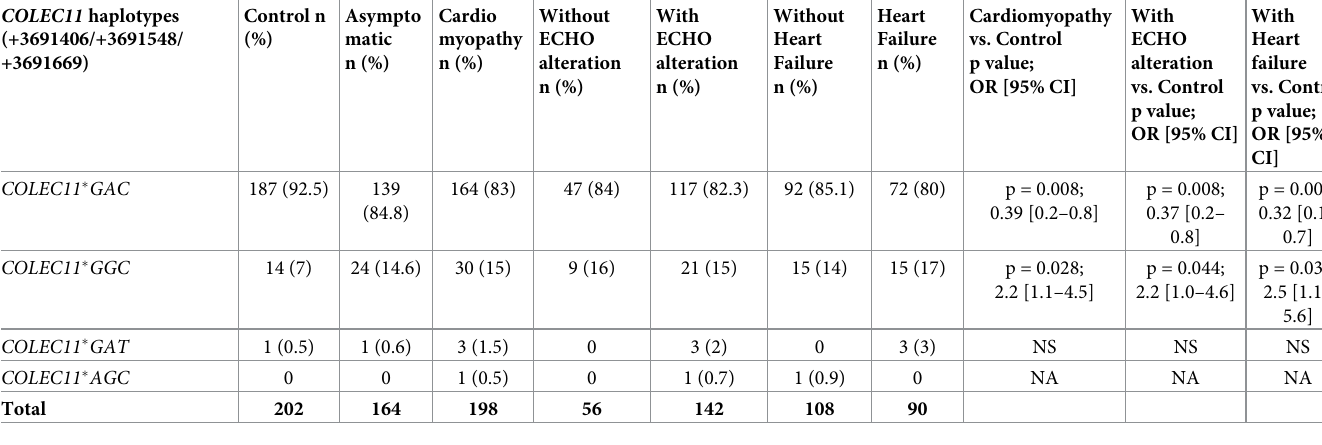
gene-gene interaction in case-control association studies, a dimension reduction method (MB-MDR) was applied to check the association of COLEC11 AG+GG and MASP2 � CD geno- types with a risk phenotype for CD. With this approach, COLEC11 and MASP2 risk genotypes presented high risk interaction for CD, which remained significant even after adjustment (considering 100 permutations) for patients with cardiomyopathy when compared to controls (adjusted permutation p = 0.05) and for patients with cardiodigestive form compared to asymptomatic but infected individuals (adjusted permutation p = 0.04). Table 5. Reconstructed COLEC11 haplotypes among patients with cardiac form of CD and healthy controls.